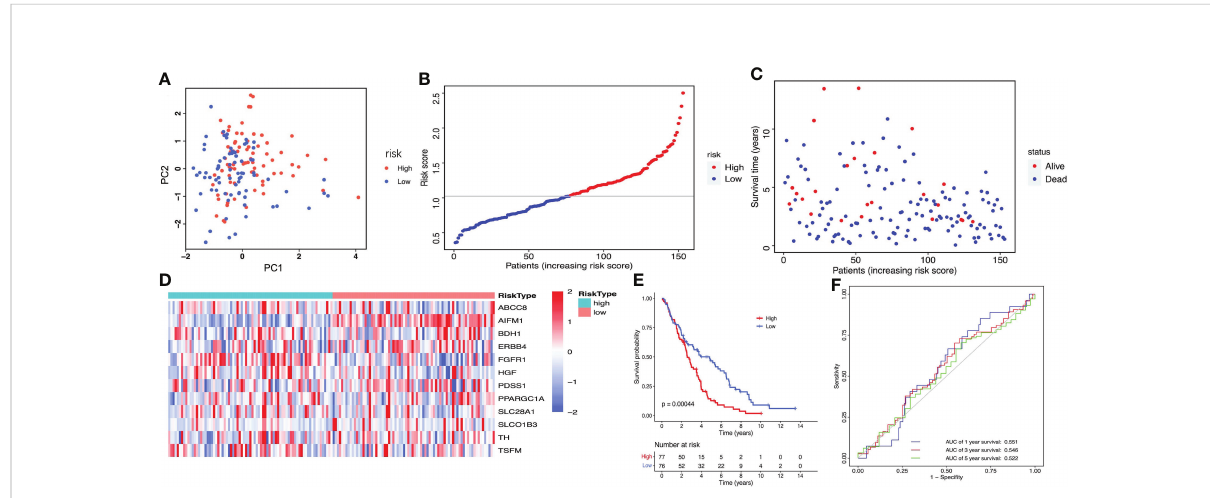
FIGURE 5 Validation of the LMRGs-based prognostic risk signature in the GSE26712 dataset. (A) PCA was used to determine whether the samples could be grouped correctly based on the prognostic risk signature. (B) The risk score distribution of patients with ovarian cancer. (C) Survival status of patients with ovarian cancer. (D) Heatmap of the 12 LMRGs expression. (E) Survival curves for the low- and high-risk groups. (F) ROC curves analysis of the risk signature on OS at 1 year, 3 years, and 5